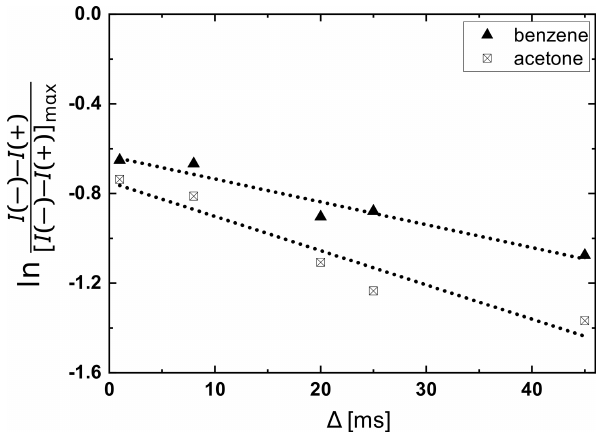
Figure 6. 1 H SNGE attenuation experiments in a 1 : 1 acetone– benzene mixture for different delays (cid:49) between G 1 and G 2 , us- ing the three-gradient sequence. The data set (top; triangles) for = 91 to 95ms) the benzene component (chemical shift 7 . 2ppm; T ∗ 2 and the data set (bottom) for the acetone component (chemical shift = 60 to 65ms) are shown. (cid:49) varied from 0 to 45ms 2 . 1ppm, T ∗ 2 at constant parameters of G 1 = 31 . 5, G 2 = 60 . 1, G 3 = 1 . 6 mT . m ( δ 1 = 2, δ 2 = 1ms, a gradient stabilization delay (cid:15) = 0 . 05ms, and an acquisition time t aq = 3 . 69ms). The respective SNGE spectra at (cid:49) = 8 and 20ms conditions are shown in Fig.